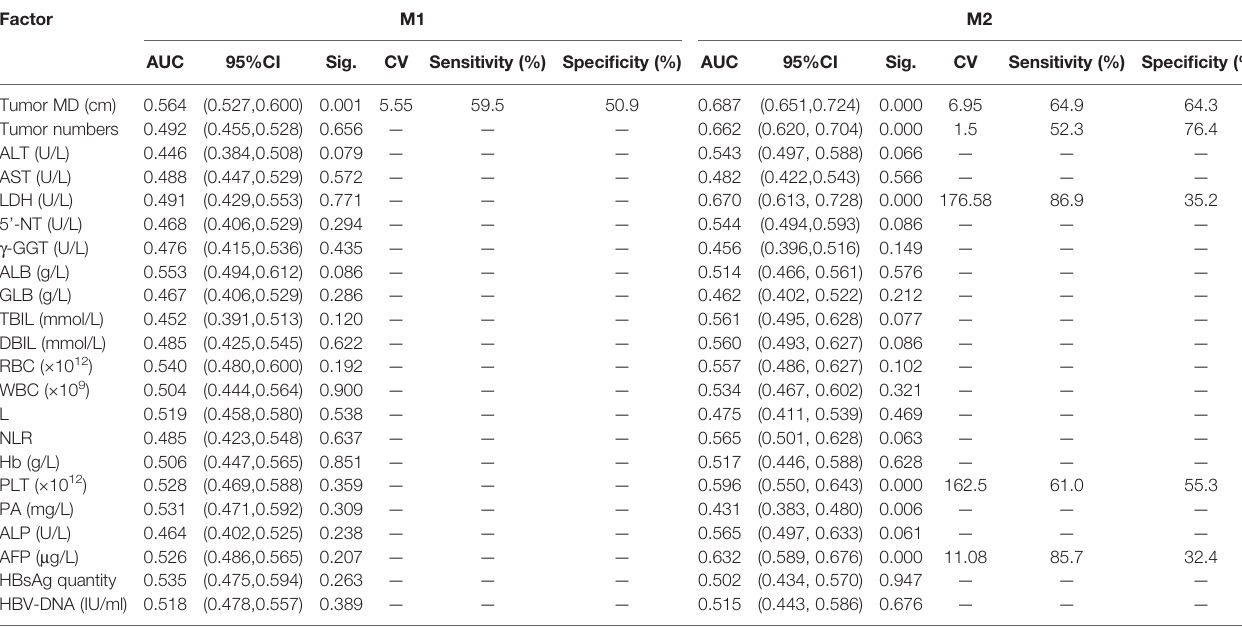
TABLE 2 | Determination of cutoff points for clinical factors determined by ROC curve analysis. Factor M1 M2 AUC 95%CI